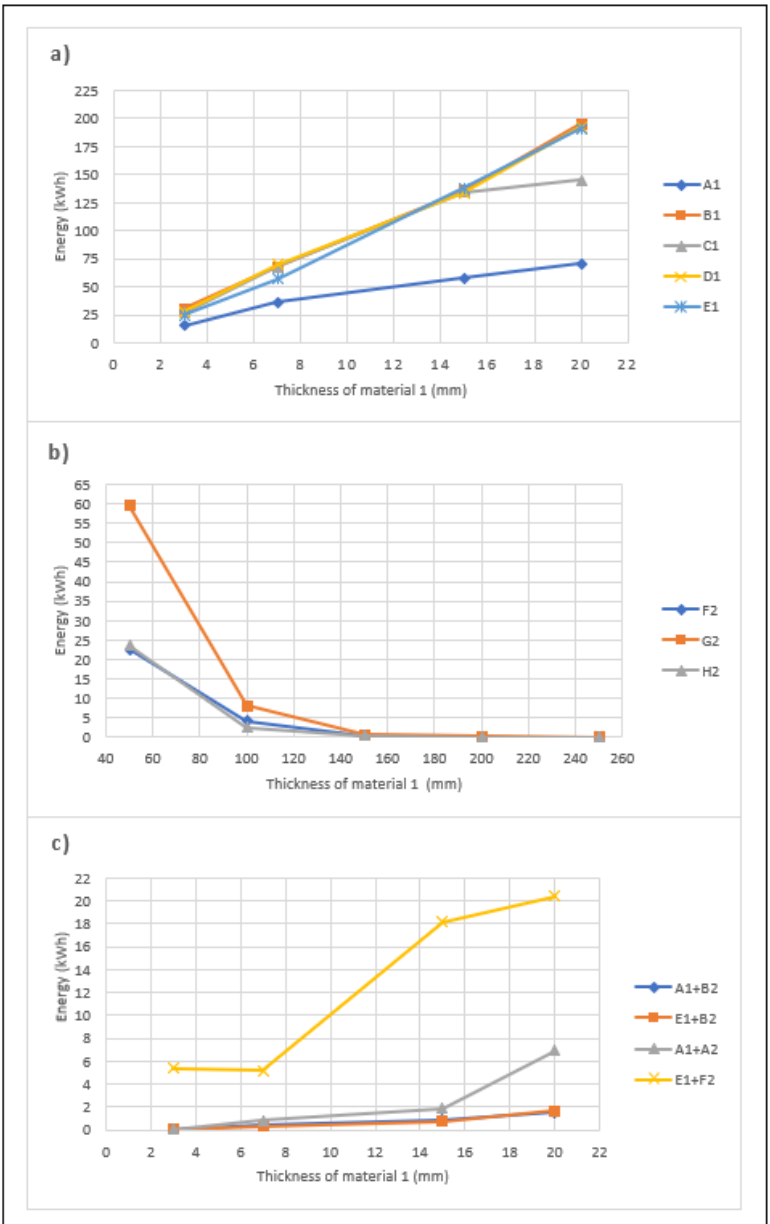
Figure 5. Heat loss through the sidewalls during the heating phase for different thicknesses and configurations; ( a ) metallic materials (configuration I); ( b ) ceramic materials (configuration I); and ( c ) material composition (configuration II or III – without pivoting side walls).